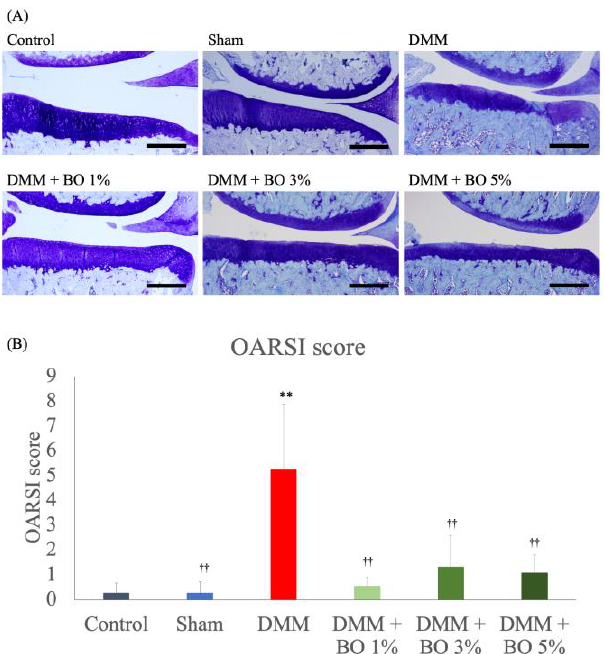
Figure 3. Histological analysis for the development of KOA assessed with OARSI score. ( A ) Representative pictures of the toluidine blue – stained right knee samples in each group. Magnification: ×40. Scale bars = 200 μ m. ( B ) At least 3 slices of the paraffin – embedded knee samples were prepared, stained by toluidine blue, and pictured with Olympus BX 53 microscope (Olympus, Tokyo, Japan). Articular cartilage degeneration (0 – 15 points), subchondral bone damage (0 – 5 points), and osteophyte formation (0 – 4 points) were measured and total score of the three parameters (0 – 24 points) was identified as the OARSI score of each rat. ** p < 0.01 vs. Control, †† p < 0.01 vs. DMM by Tukey-Kramer test. BO; Boiogito, DMM; Destabilization of the medial meniscus, KOA: knee osteoarthritis, OARSI; Osteoarthritis Research Society